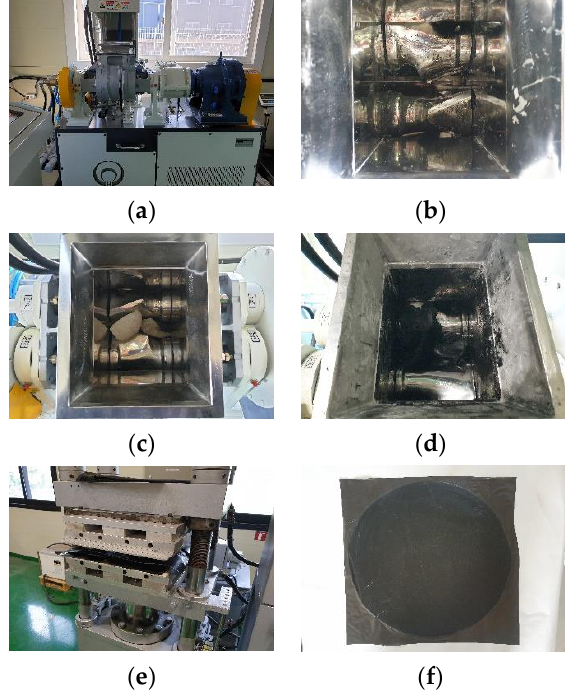
Figure 3. Test sample mixing status. ( a ) Kneader used in research; ( b ) Compounding part; ( c ) Raw material input; ( d ) Mixing; ( e ) Hydraulic press; ( f ) Test sample.